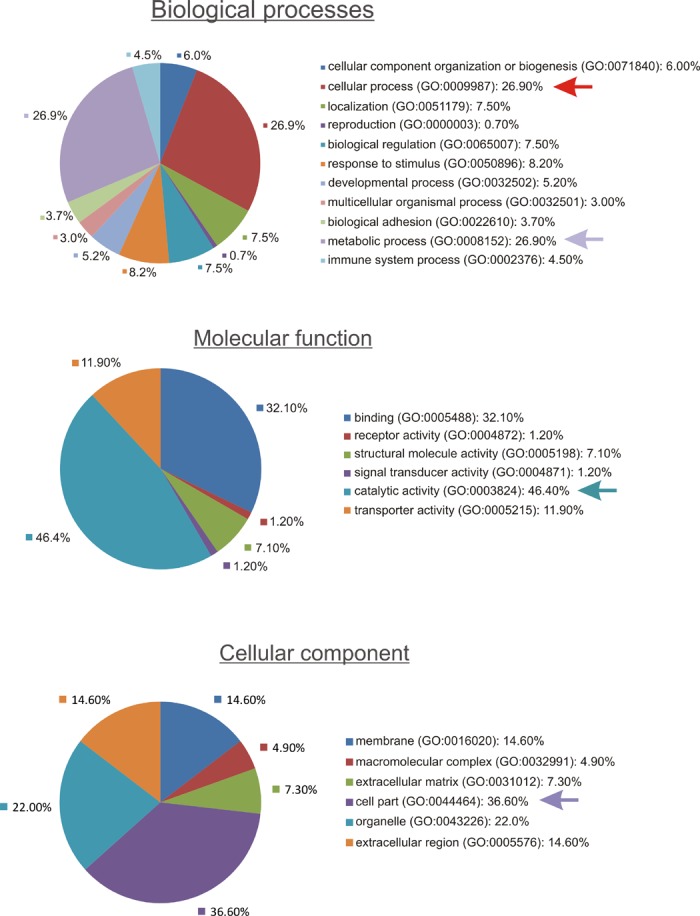
Functional annotation of proteins that were differently expressed in DIO1(+) cells when compared with DIO1(-) cells.The pie charts show results of analysis performed using PANTHER (http://pantherdb.org). The largest categories of biological processes, molecular function, and cellular components related to the identified proteins are shown with arrows.